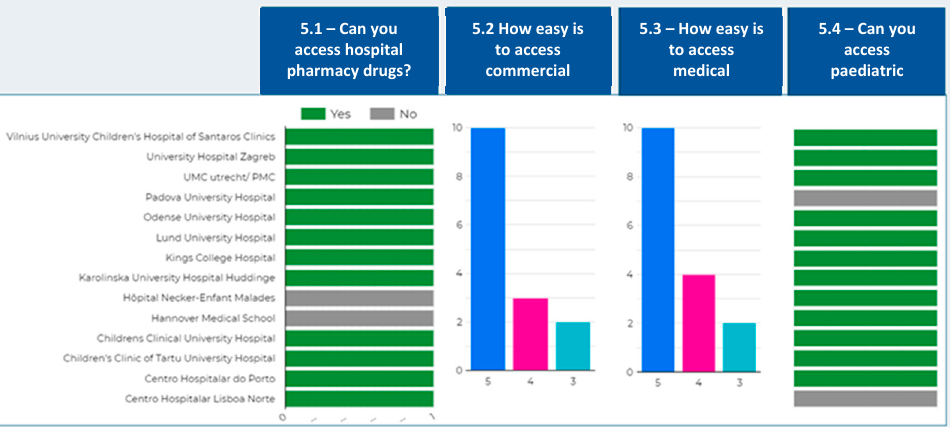
Figure 4. Accessibility to medicines. From left to right, hospital pharmacy drugs, commercial pharmacy drugs, medical equipment, and paediatric doses. For 5.2 and 5.3, Y -axis, number of responses; X -axis, Likert scale (3 = acceptable, 4 = easy, 5 = very easy).